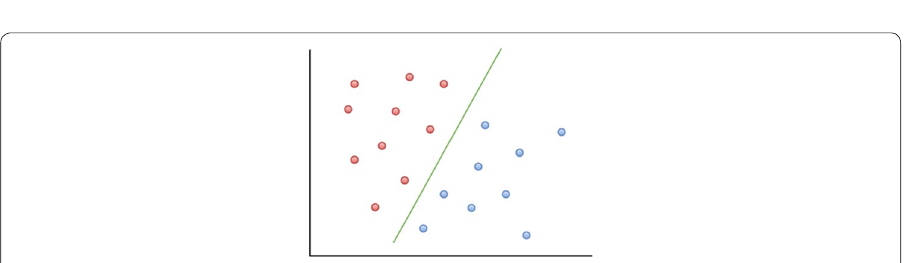
Fig. 2 Support vector machine data distribution over the